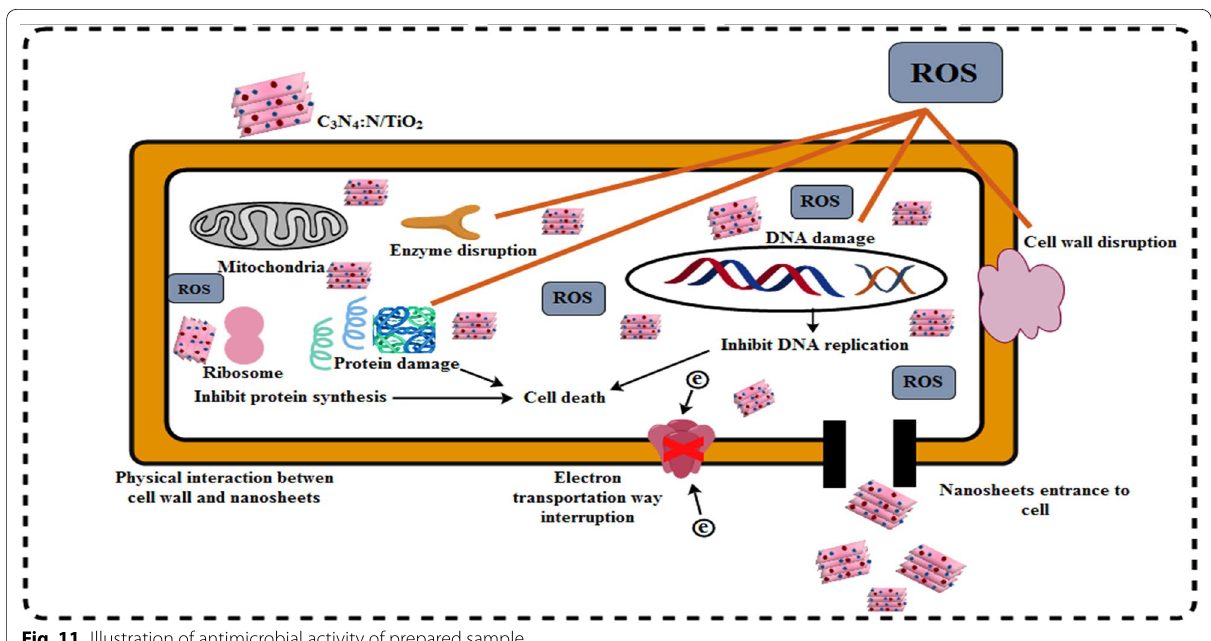
Fig. 11 Illustration of antimicrobial activity of prepared sample